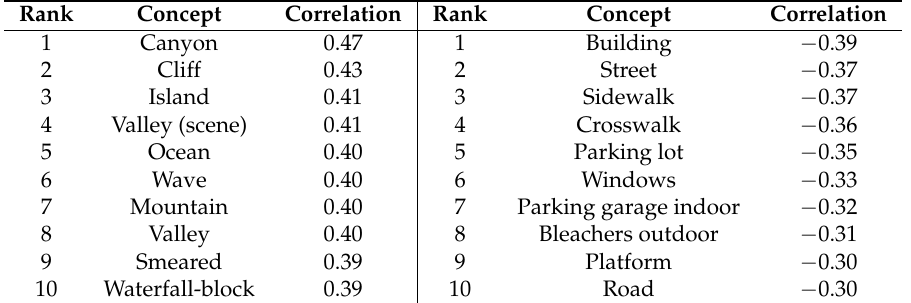
Table 1. Top 10 Broden concepts positively (left) and negatively (right) correlated to scenicness.